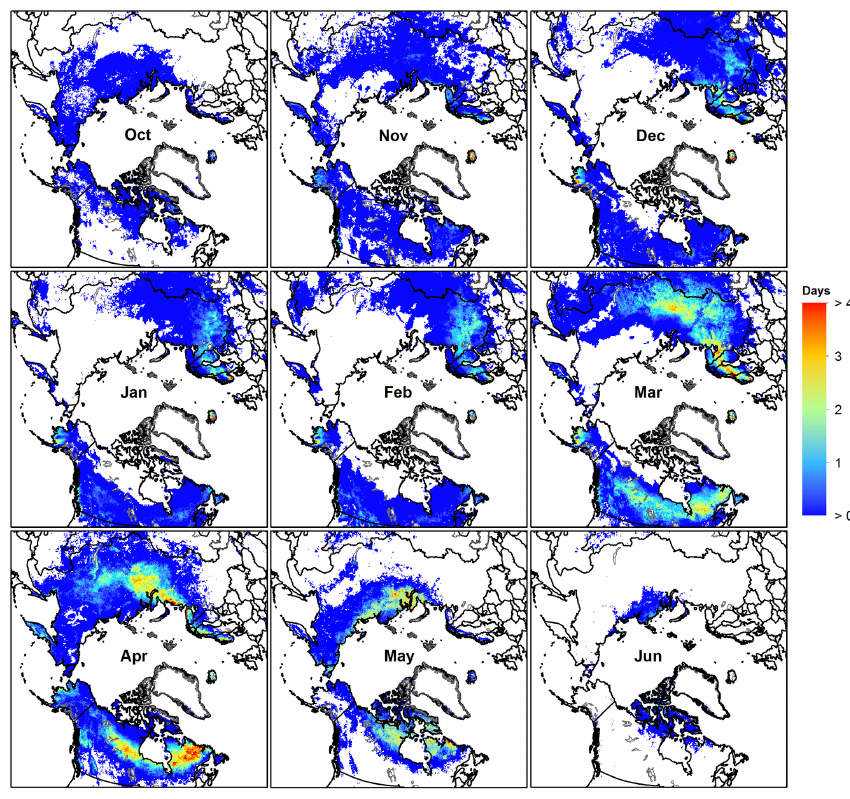
Figure 7. Monthly mean number of melting days from PMW during the period 1988–2013.